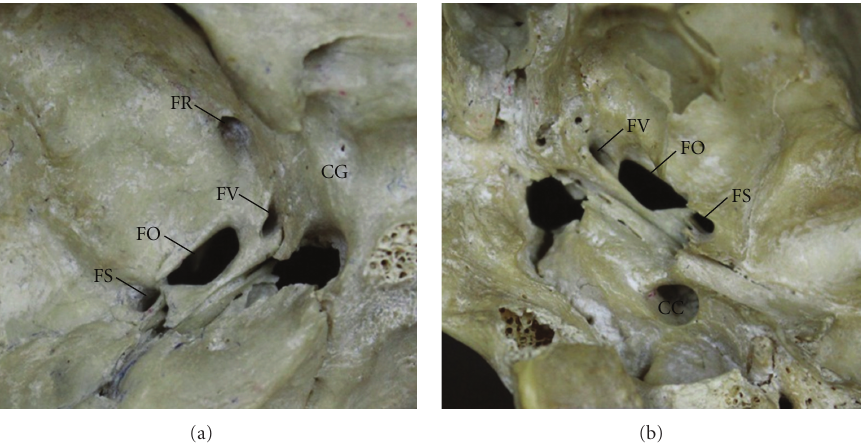
Figure 2: The patent FV viewed from the middle cranial fossa (a) and the extracranial view of the skull base (b). CC: carotid canal; CG: carotid groove; FL: foramen lacerum; FO: foramen ovale; FR: foramen rotundum; FS: foramen spinosum; FV: foramen of Vesalius. Table 2: Distribution of the unilateral and bilateral FV found in analyzed dry skulls according to side and sex. Groups Patent FV [Skulls (%)] FV in middle cranial fossa [Skulls (%)] ( N , skulls) Total sides Right side Left side ( N =